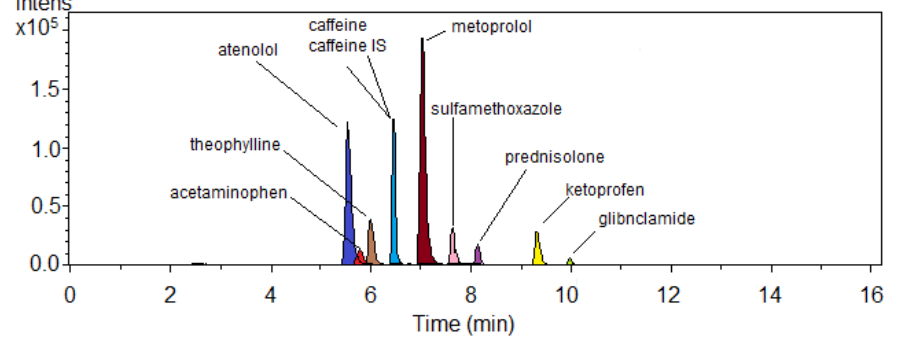
Figure 3. Representative liquid chromatography-time of flight/mass spectrometry of a standard solution of the pharmaceutical compounds determined in this study.